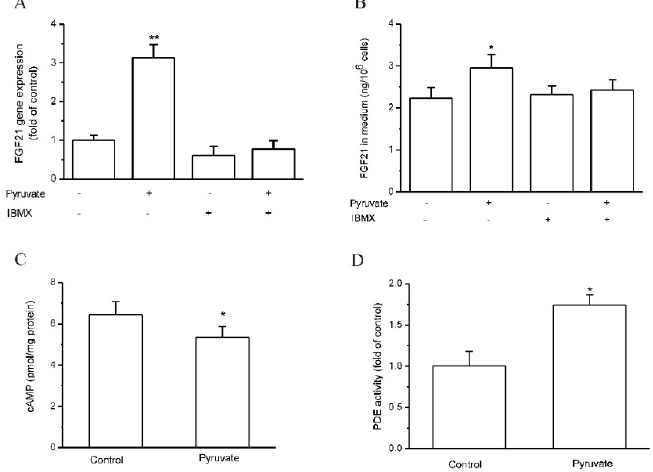
Figure 5. Pyruvate upregulated FGF21 expression and secretion in mouse hepatic AML-12 cells. ( A , B ): Pyruvate stimulated FGF21 expression and secretion in AML-12 cells (* p < 0.05 and ** p < 0.01 vs. control, n = 6). ( C ): Pyruvate decreased intracellular cAMP levels in AML12 cells (* p < 0.05, n = 5). ( D ): Pyruvate increased PDE activities in AML-12 cells (* p < 0.05, n = 5).